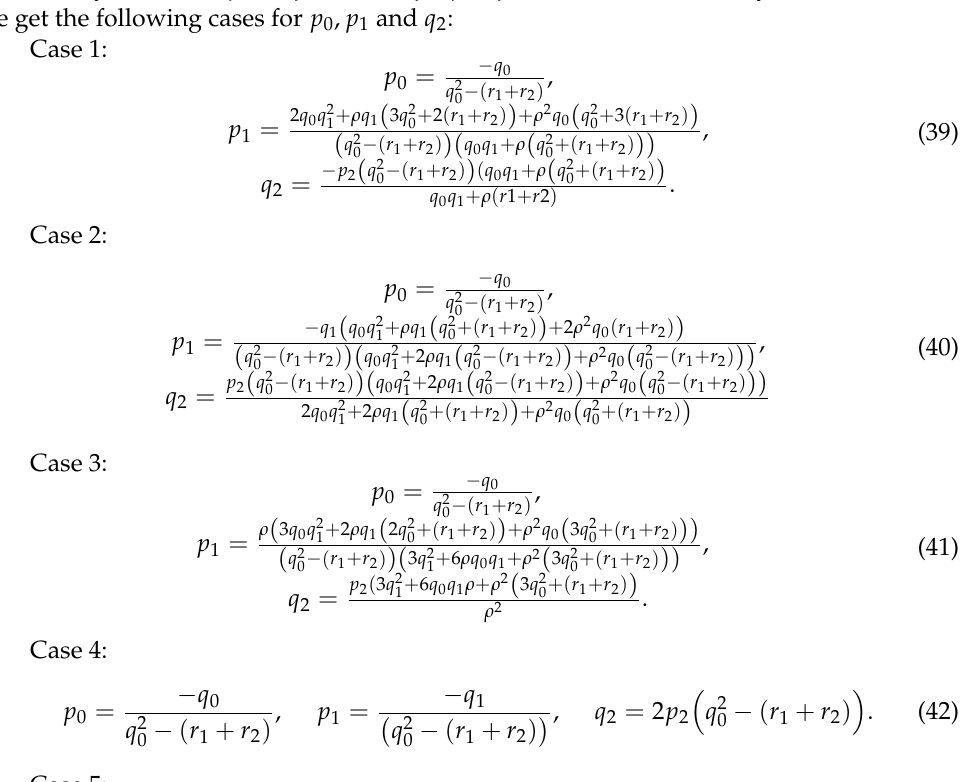
and with the parameters and for the fractional order 𝐹𝐹 7 ( 𝑥𝑥 , 𝑑𝑑 ) 𝐺𝐺 7 ( 𝑥𝑥 , 𝑑𝑑 ) 𝜏𝜏 = 0 𝛼𝛼 = be arbitrary constants. Then,